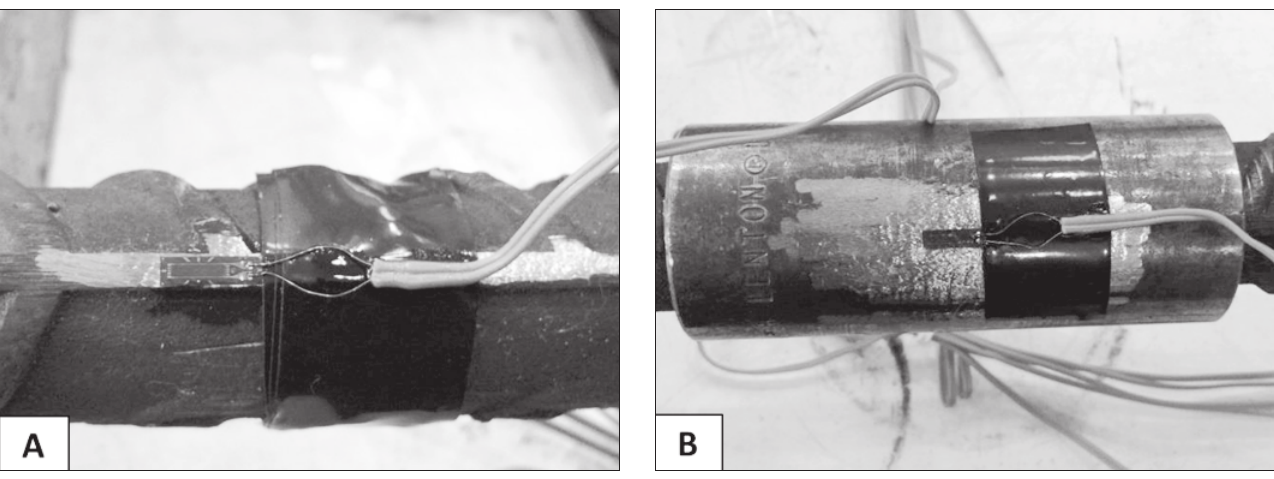
Detail of electrical extensometers: A - steel bar and B - coupler